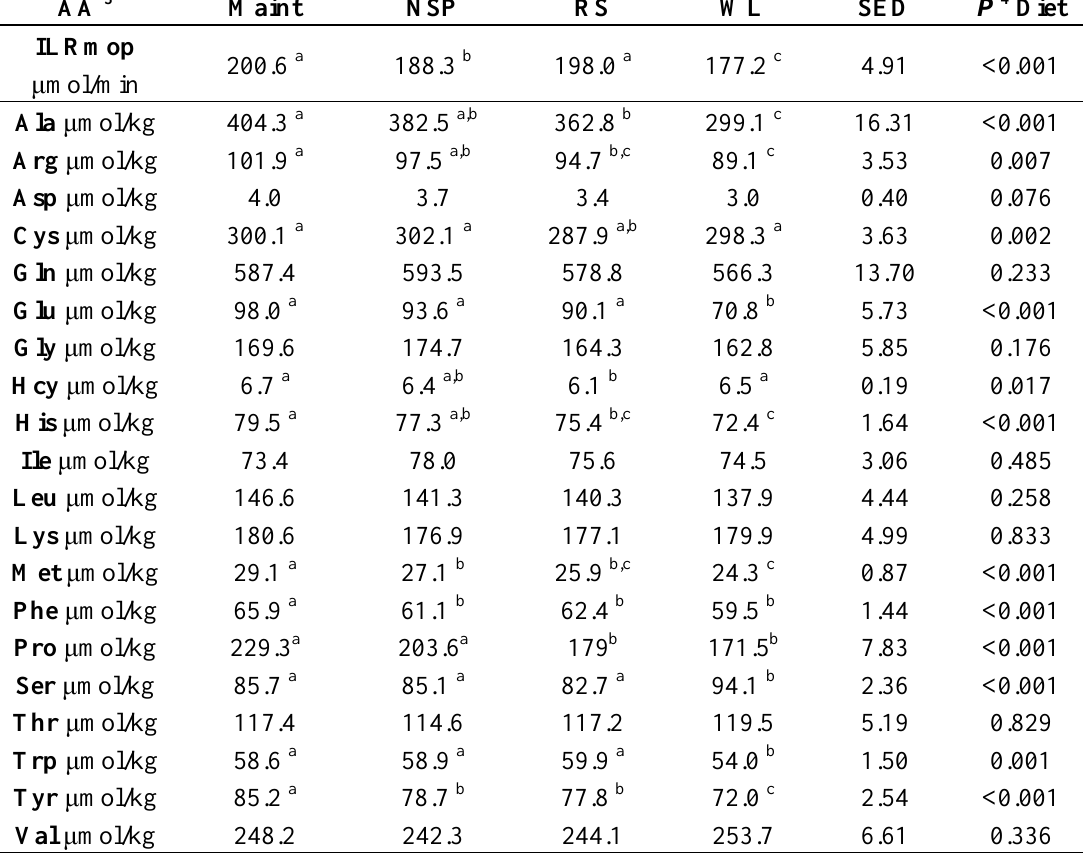
Table 2. Overnight fasted irreversible loss rate (ILR; based on plasma MOP 1 ) and plasma amino acid concentrations (µMolal) at the end of each dietary intervention period 2 for 14